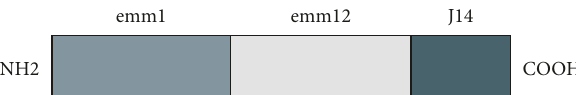
Figure 1: Schematic diagram of the vaccine. The vaccine is a signal peptide composed of 84 amino acids: GFANQTEVKANGDGNPRE- VIEDLAANNPAIQNIRLDHSDLVAEKQRLEDLGQKFERLKQRSE- LYLQQYYDASREAKKQVEKALE. The first 35 amino acid sequence (GFANQTEVKANGDGNPREVIEDLAANNPAIQNIRL) is from N terminal of M1 protein, the next 35 amino acid sequence (DHSDLVAE KQRLEDLGQKFERLKQRSELYLQQYYD) is from N terminal of M12 protein, and the last 14 amino acid sequence(ASREAKKQVEKALE) is the J14